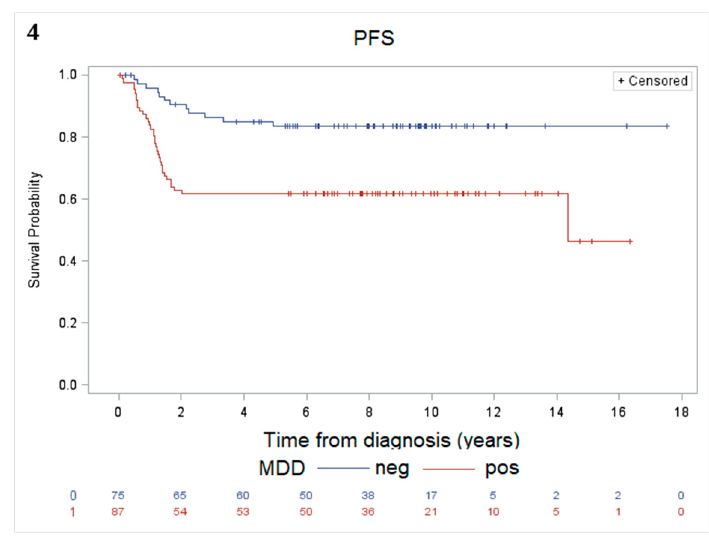
Figure 4. The 10-year PFS according to MDD stratification was 62% (SE ± 5%) for the MDD positive patients and 83% (SE ± 4%) for the MDD negative patients, p = 0.001.